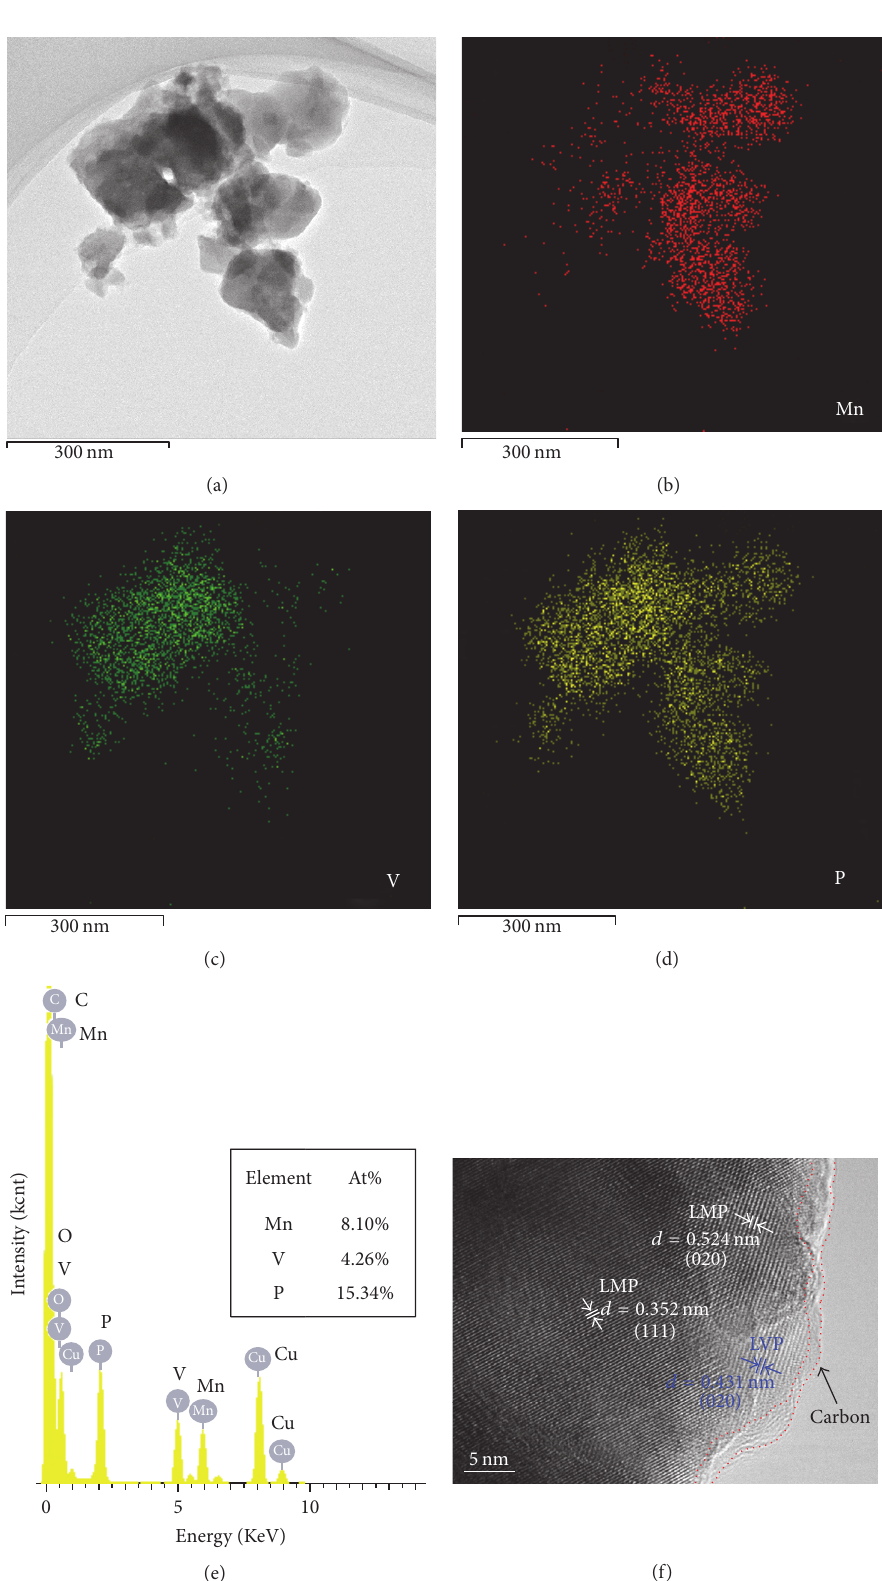
Figure 3: Elemental mappings for Mn, V, P ((a)–(d)); EDS spectrum (e); HRTEM image of 4LMP ⋅ LVP/C